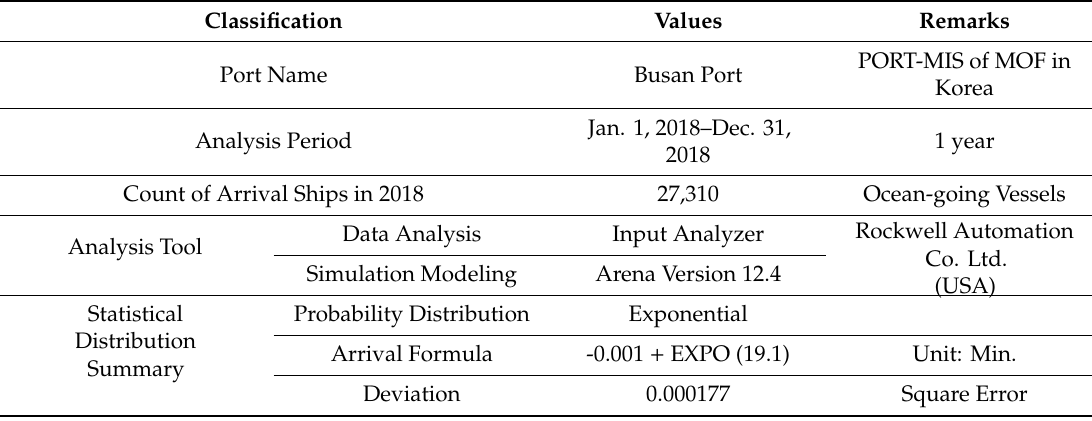
Table 15. Ship Arrival and Arrival Distribution of Busan Port in